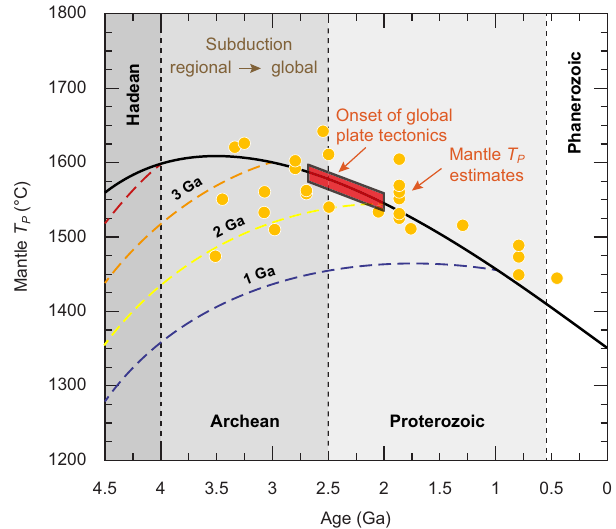
Fig. 5 | Modeled thermal histories. Modeled thermal histories with a switch in heat- fl owscalingfromstagnant-lidconvectiontoplatetectonicsat1Ga(blue),2Ga (yellow), 3Ga (orange), and 4Ga (red), while a case entirely with plate tectonics scaling is shown in solid (see ref. 83 for modeling details). Red box shows onset range for global subduction with 2.7Ga as an upper bound (this study) and 2.0Ga asalowerbound 61 ,consistentwithestimatesofmantlepotentialtemperature( T p ) 45 as compared to thermal